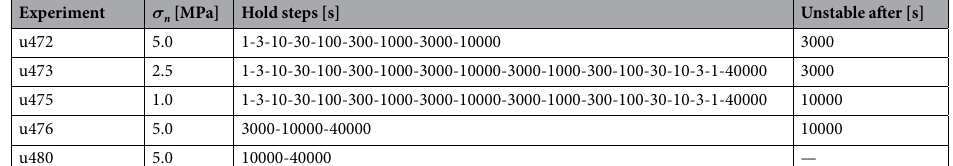
Table 1. List of laboratory experiments with the applied normal stress, the range of hold durations, and indication of the hold step after which the first unstable slip event occurred. Experiment u480 was unloaded prior to resliding to get a near-direct measurement of the cohesion.